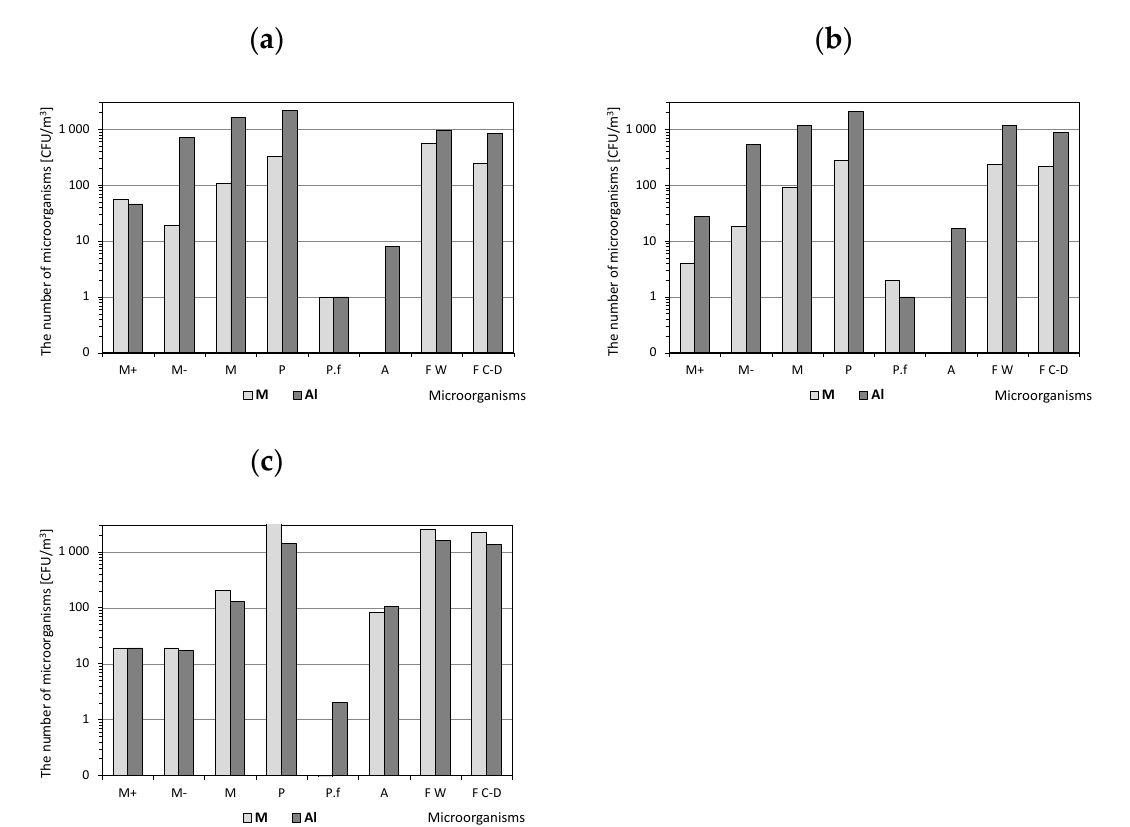
Figure 3. Average number of bacteria and microscopic fungi in the morning (M) and after lessons (Al), ( a ) in classroom 04, ( b ) in classroom 105, ( c ) outdoor air (research background). M+—mannitol-positive Staphylococcus ; M − —mannitol-negative Staphylococcus ; M—mesophilic bacteria; P—psychrophilic bacteria; P.f— Pseudomonas fluorescens ; A— Actinobacteria ; F W—microscopic fungi on Waksman medium; F C-D—microscopic fungi on Czapek-Doxa medium.